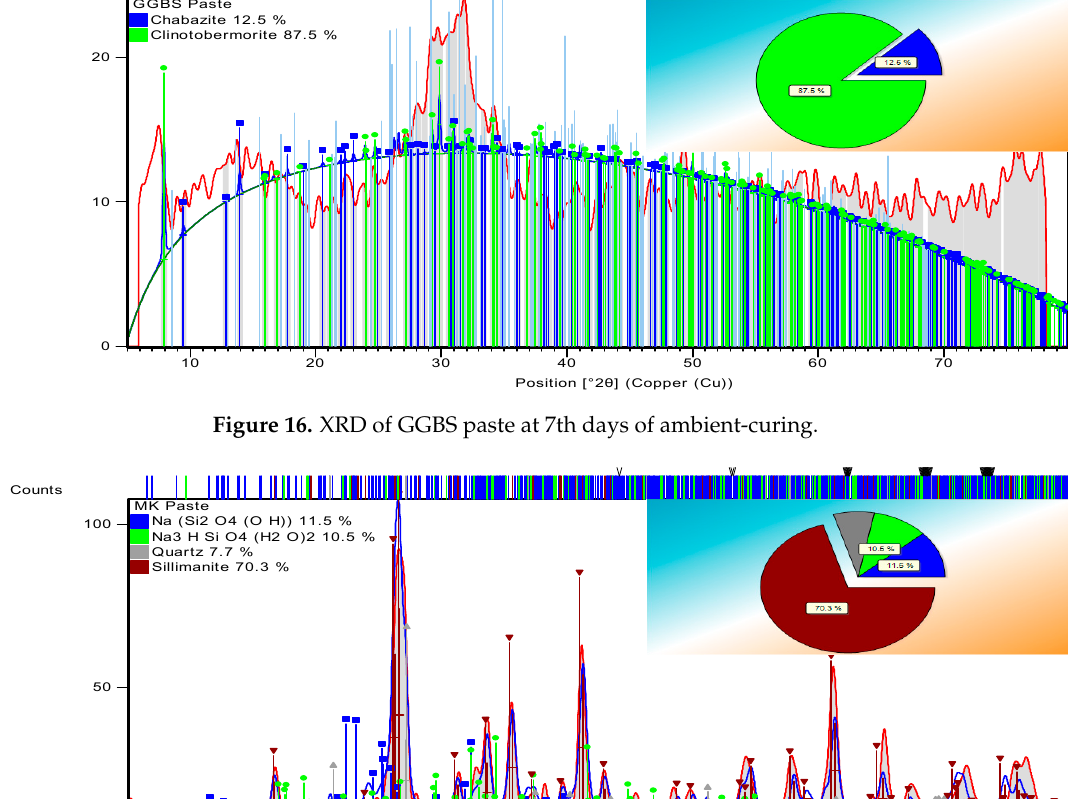
Figure 15. XRD of Fly ash paste at 7 days of ambient curing.